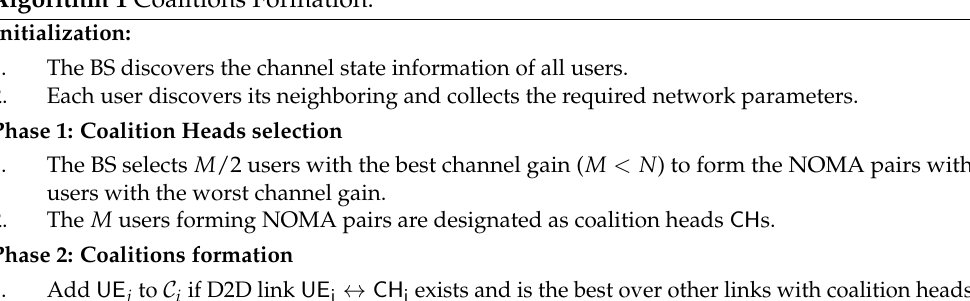
Algorithm 1 Coalitions